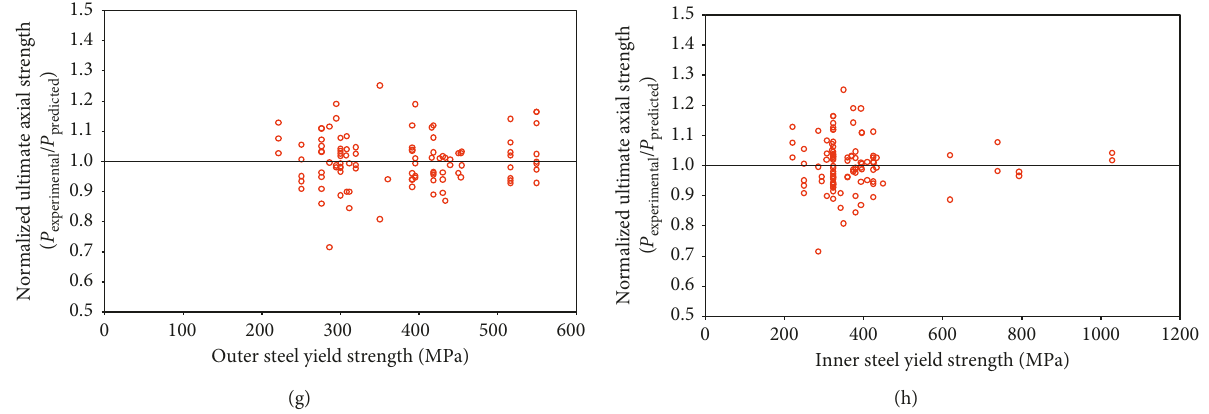
Figure 6: Interaction between the prediction capability of the proposed model and specimen properties. (a) Hollow ratio ( χ ). (b) Length-to- outer steel diameter ratio ( L / D o ). (c) Outer steel diameter-to-inner steel diameter ratio ( D o / D i ). (d) Outer steel diameter-to-thickness ratio ( D o / t o ). (e) Inner steel diameter-to-thickness ratio ( D i / t i ). (f) Concrete compressive strength ( f c ). (g) Outer steel yield strength ( f syo ). (h) Inner steel yield strength ( f syi ). Table 4: Comparison of the experimental ultimate axial strength of CFDST columns with the proposed and existing models.